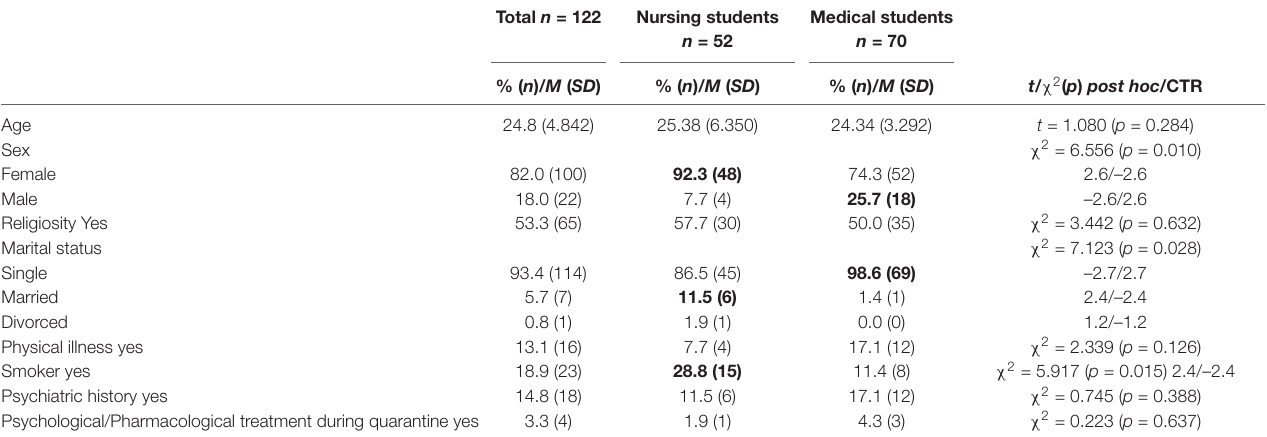
TABLE 1 | Sociodemographic characteristics and differences between the study